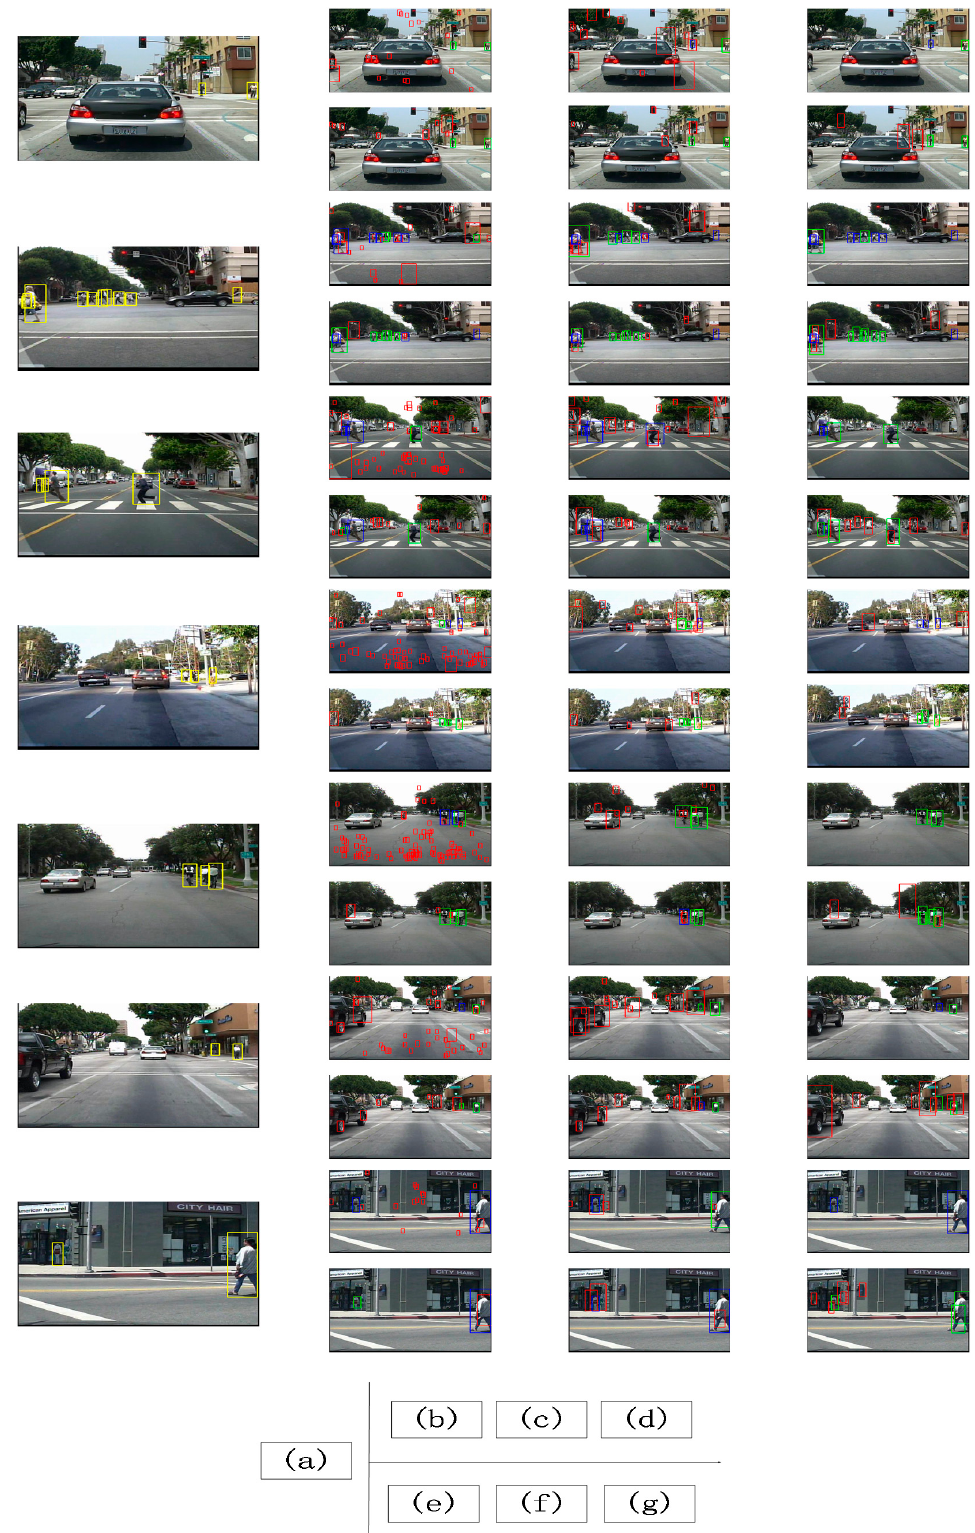
Figure 9. Detection results of models based on hand-crafted features and the improved UDN. False positive samples are in the red box. True positive samples are in the green box. False negative samples are in the purple box. ( a ) Ground Truth; ( b ) VJ; ( c ) HOG; ( d ) HOG + LBP; ( e ) ChnFtrs; ( f ) ACF; ( g ) Improved UDN. Best viewed in